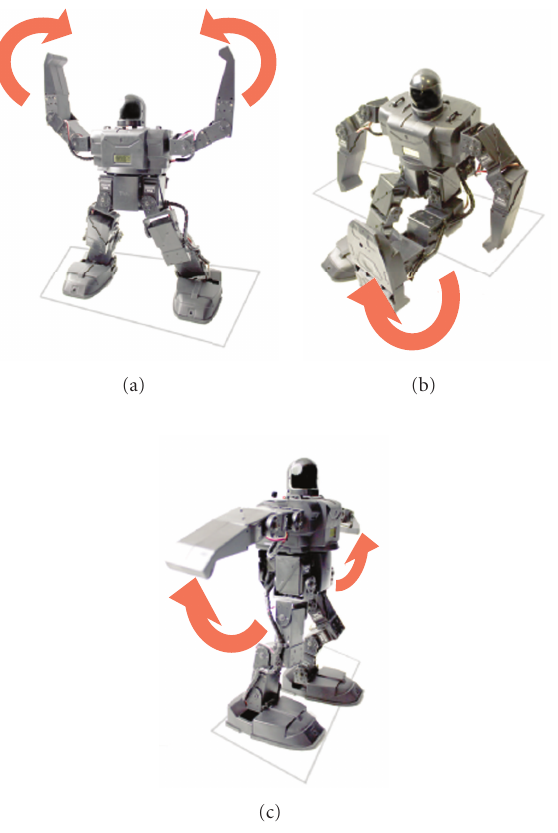
Figure 5: The set of possible exercises is determined by the physical capabilities of the humanoid robot. The robot’s 20 servo motors enable the turning movements of the head, waist, and thighs and joint movements of the